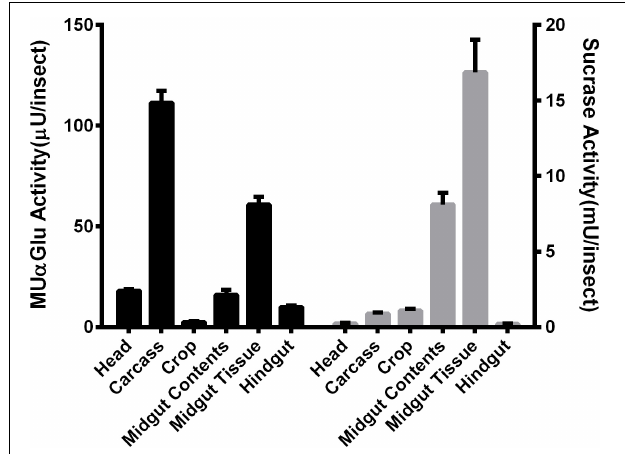
Frontiers in Physiology |